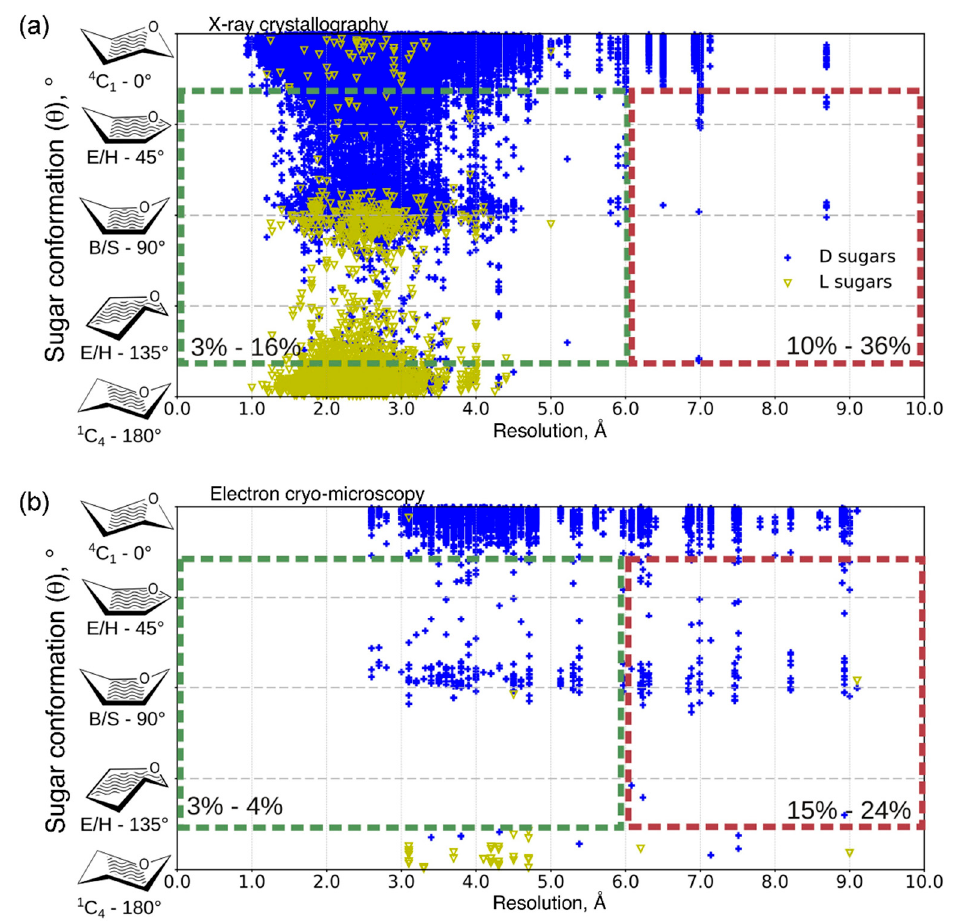
Figure 9. Distribution of D- (shown in blue) and L-pyranoside (shown in yellow) ring conformations as function of resolution for all sugar moieties in N-glycosylated proteins in PDB (on April 2019) solved with ( a ) X-ray crystallography and ( b ) electron cryo-microscopy. Non-chair conformations are bordered by dotted line boxes for 0.0-6.0 Å (green) and 6.0-10.0 Å (red) resolution ranges; the percentage of structures is given in the boxes. Reproduced with permission from [301], © 2020 Elsevier Ltd.